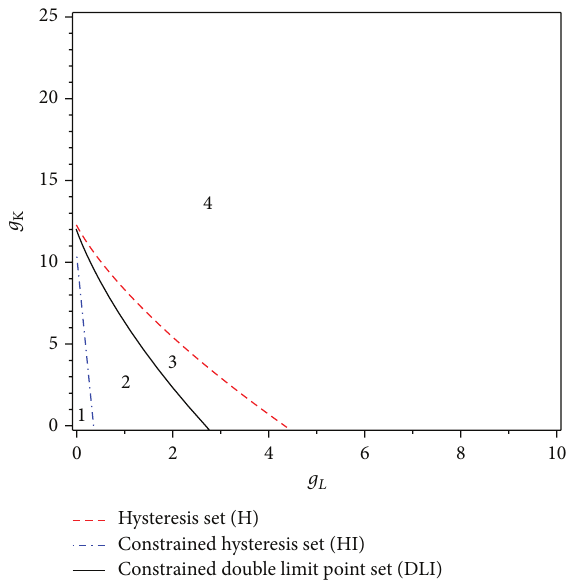
Figure 1: Constraint transition